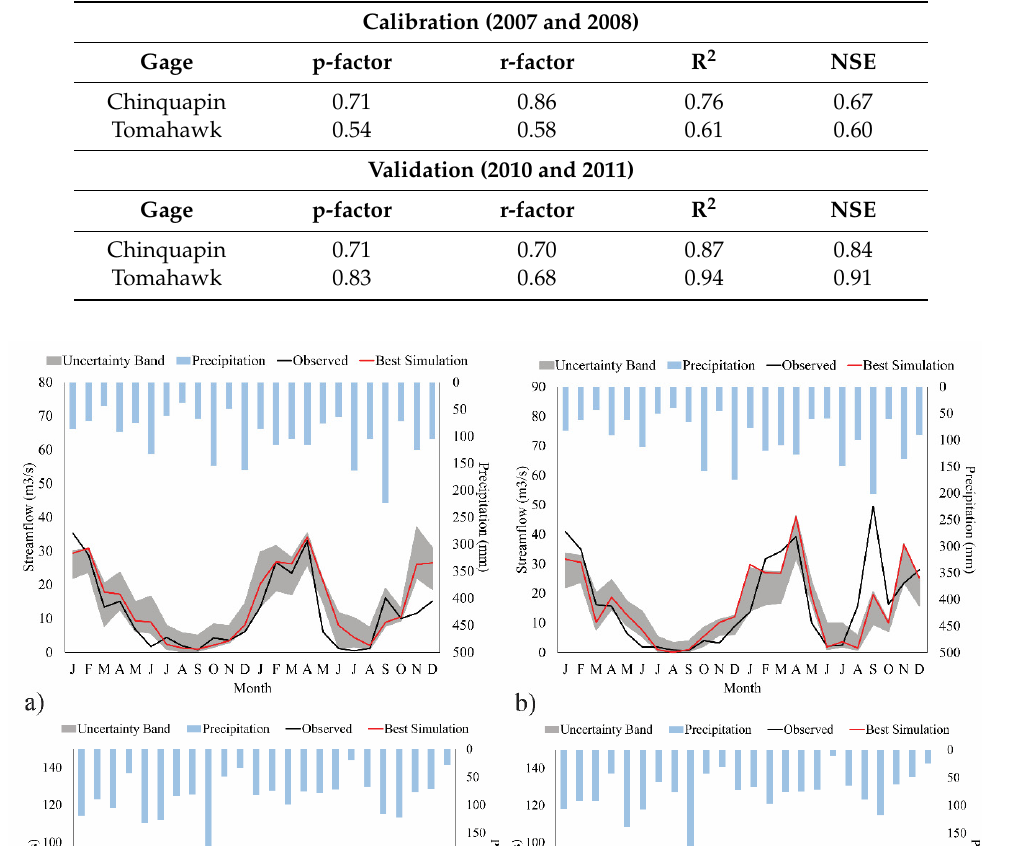
Table 6. SWAT Calibration and Uncertainty Program (SWAT-CUP) objective function results for the calibration and validation periods.